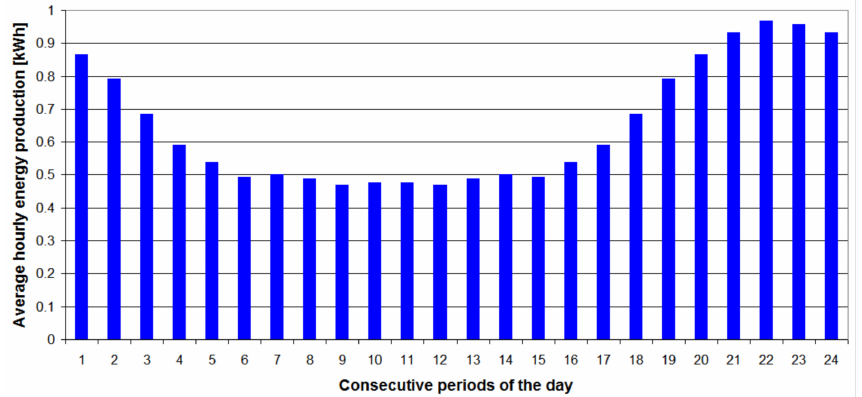
Figure 3. Daily variability of wind turbine energy generation.